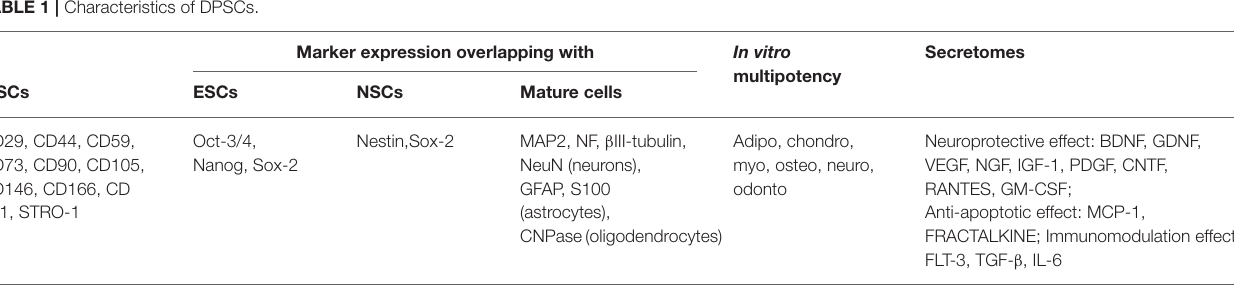
TABLE 1 | Characteristics of